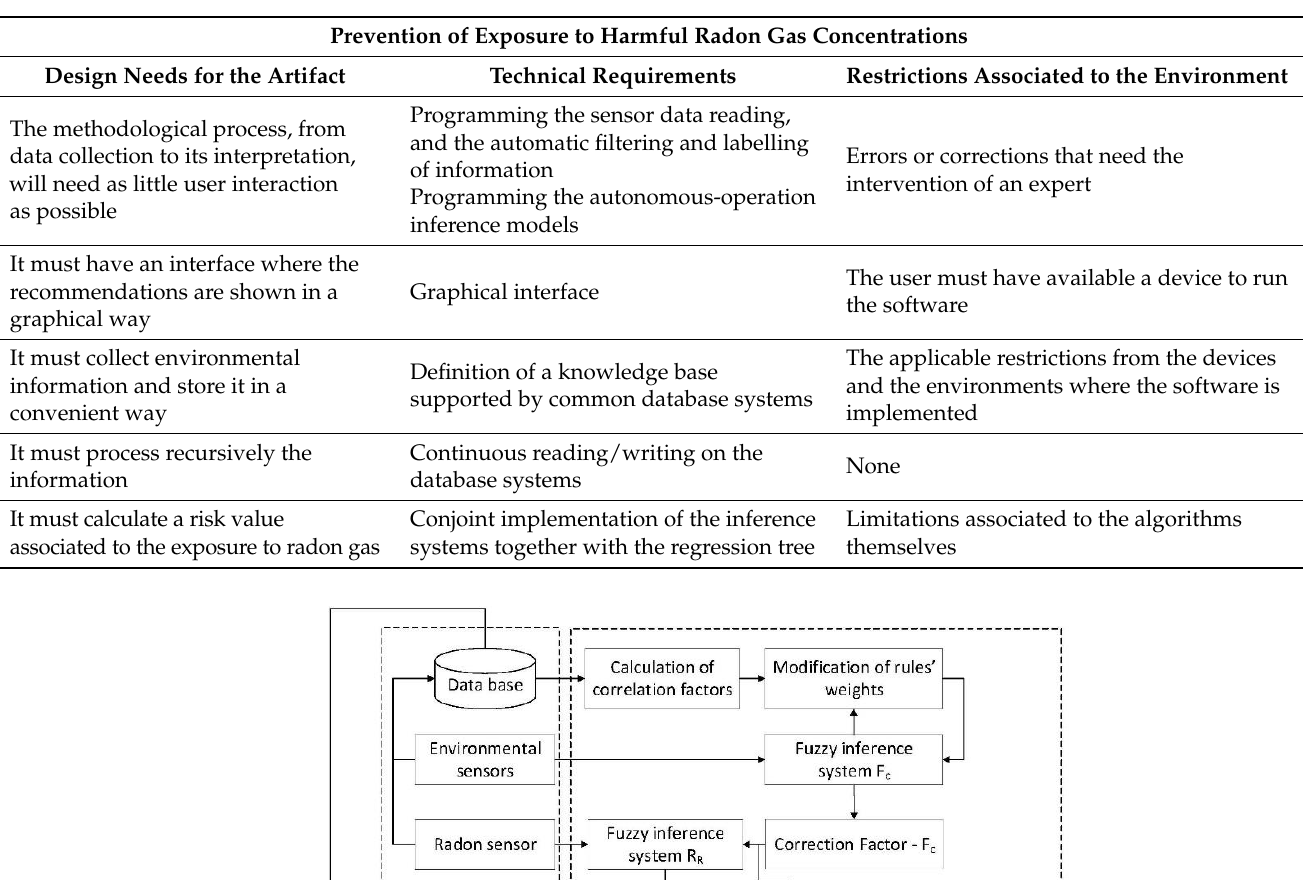
Table 3. Design needs, requirements, and their corresponding restrictions.